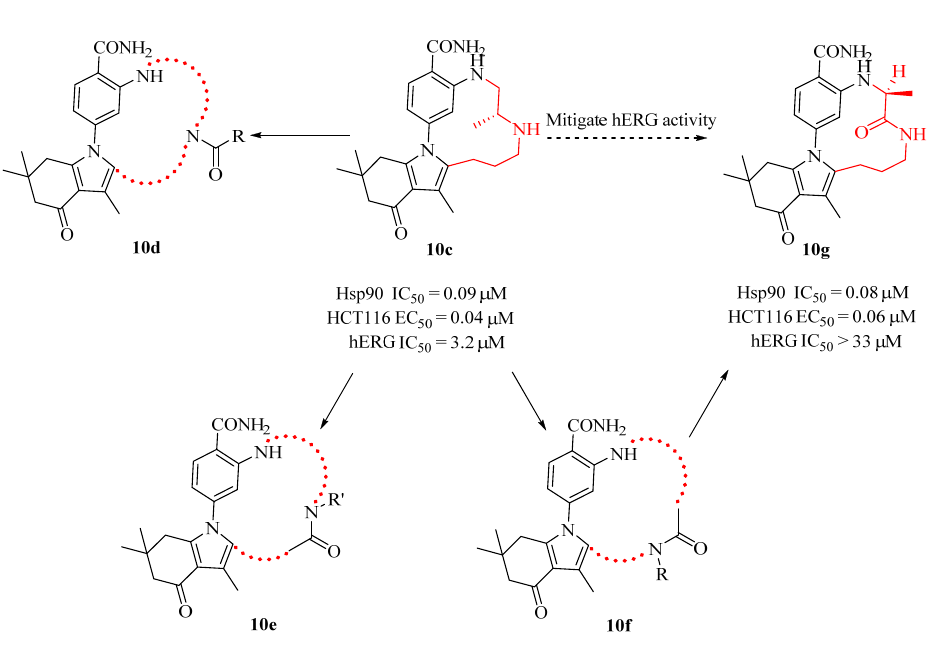
Figure 12. Compound 10g and other discussed structures.